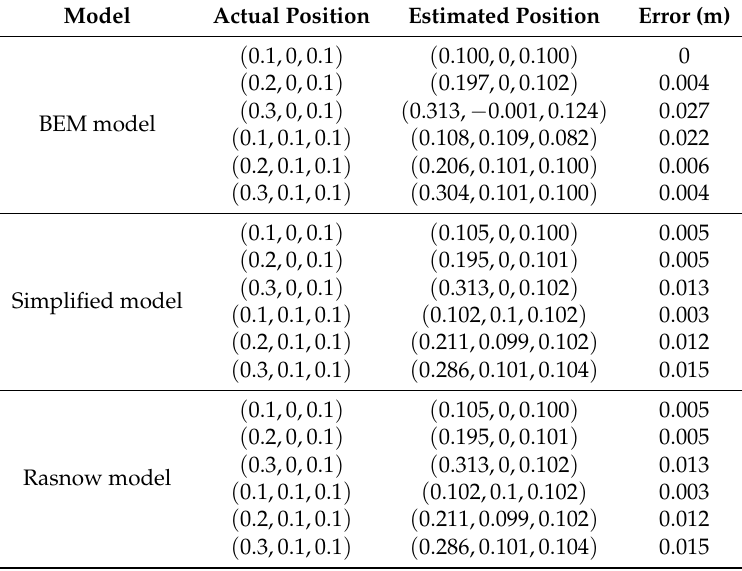
Table 4. The estimated positions of the electric dipole source in different